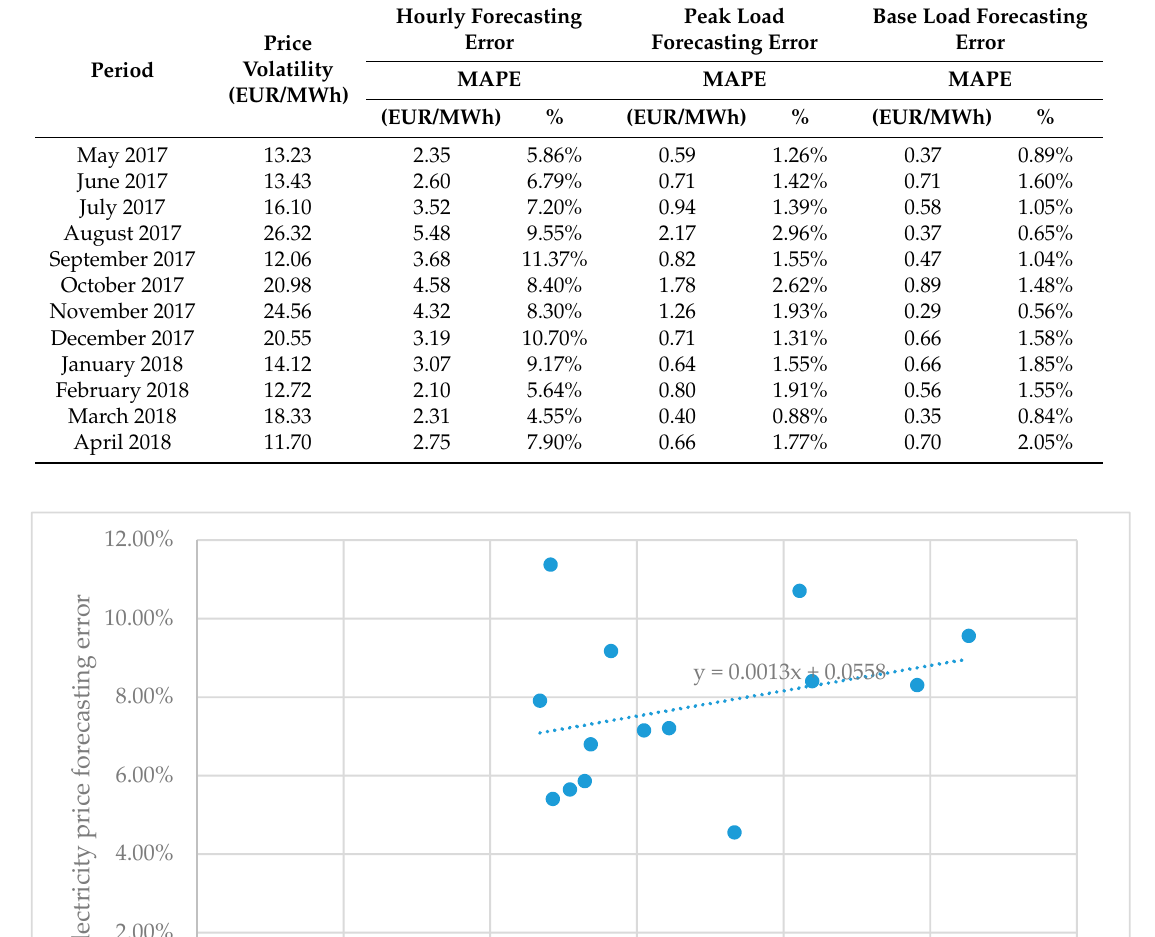
Table 5. Simulation results for electricity price forecast calculated with similar day method in the 3rd forecasting interval.